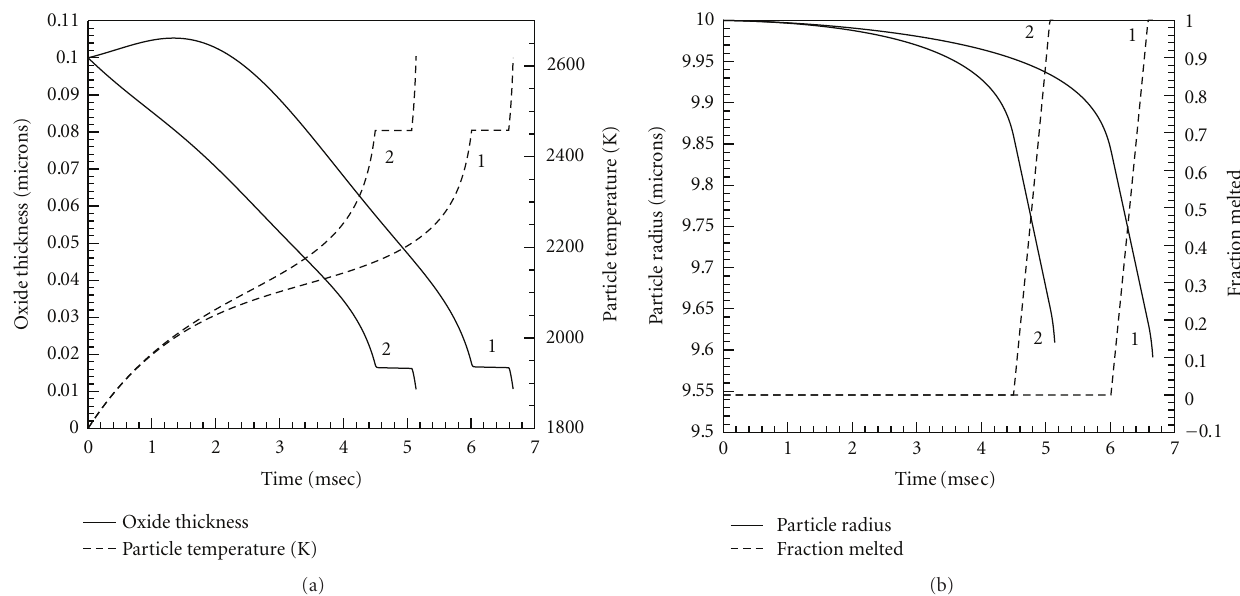
Figure 3: Predicted time dependence of important variables for particle which ignites at ambient temperature of 2100 K ((a) King’s model (b) our model with film